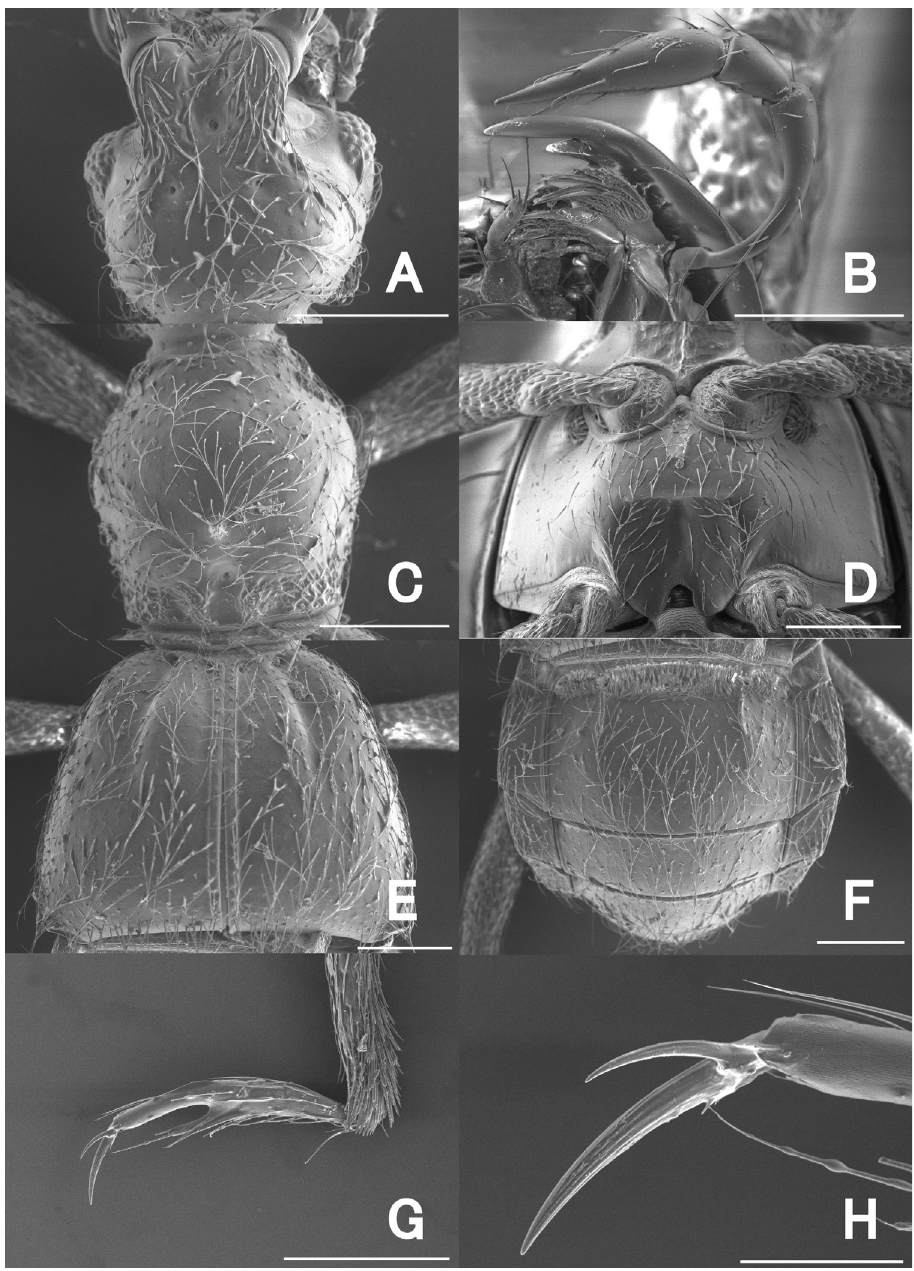
Figure 3. SEM images of Pseudophanias yaimensis , male A head B maxillary palp C pronotum D metaventrite E elytra F abdomen G mesotarsus H mesotarsal claws. Scale bars: 0.2 mm ( A, C–G ); 0.1 mm ( B ); 0.05 mm ( H